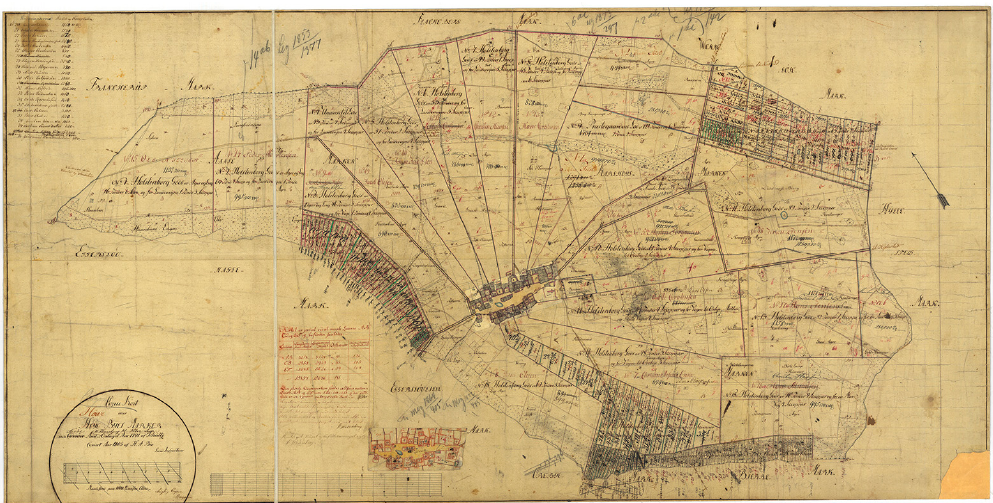
Figure 3. Map from 1806 showing Høve and its surrounding fields shortly after the Redistribution. The church is in the Eastern part of the village with the surrounding cemetery. The village is structured around a central green.